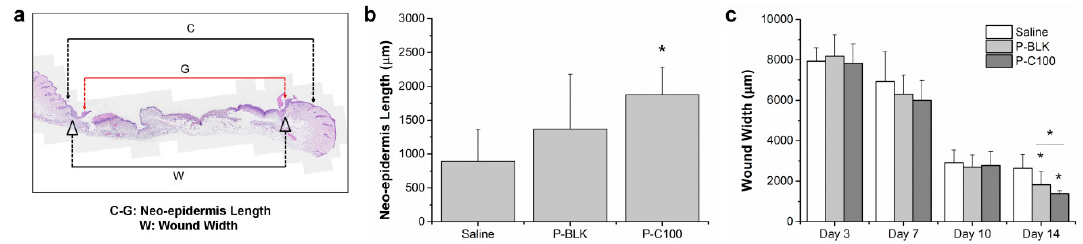
Figure 6. Schematic representation of the histologically stained wound section ( a ) and measurements of neo-epidermis length at day 3 ( b ) and wound width at indicated days ( c ). C is the distance between the first hair follicles on the wound edge. G is the distance between the advancing margins of neo-epidermis. Neo-epidermis length = C-G. W (wound width) is the distance between the cut ends of skin connective tissue. * At day 3, neo-epidermis length of P-C100 treating was larger than that of saline treatment ( p < 0.05). * At day 14, both wound width of P-BLK and P-C100 treating were smaller than that of saline treatment ( p < 0.05). Error bar represents standard deviation of means; n = 3.